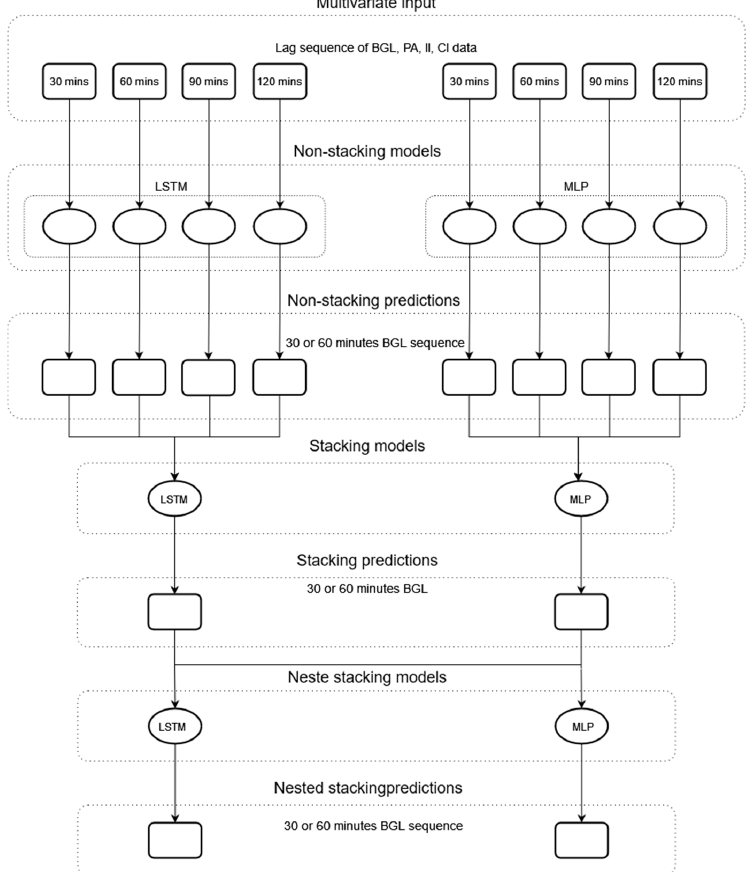
Figure 1. Blueprint for generating non-stacking, stacking, and nested stacking blood glucose level prediction models. Rectangular and oval blocks represent sequences of lag or future data and regression learners, respectively. Note. BGL: blood glucose level; PA: physical activity; II: insulin injection; CI: carbohydrate intake; LSTM: long short-term memory; MLP: multilayer perceptron.